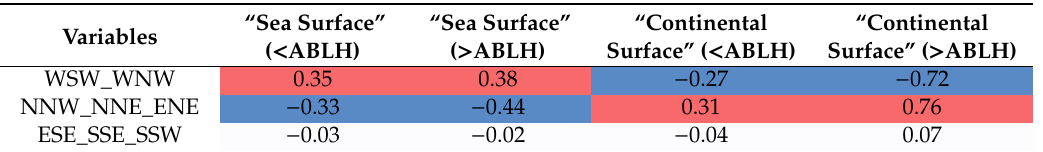
Table 1. PLS correlation matrix between clustered sector variables and zone variables. Highest correlation displayed in red and highest anti-correlation in blue.